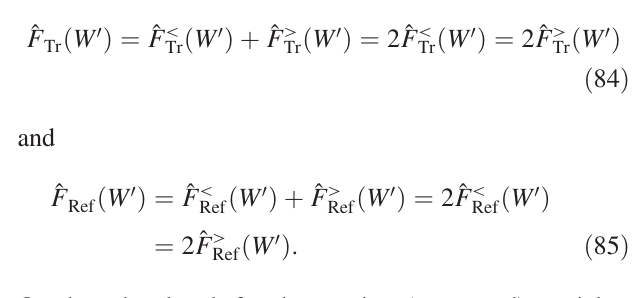
are untrapped, max < W 0 < ψ are trapped and min max